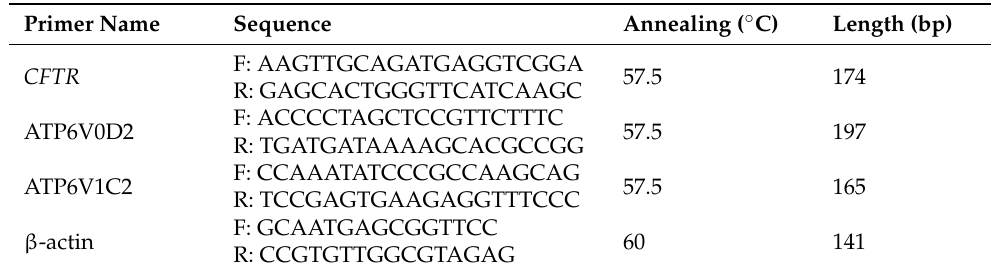
Table 1. Primer information for